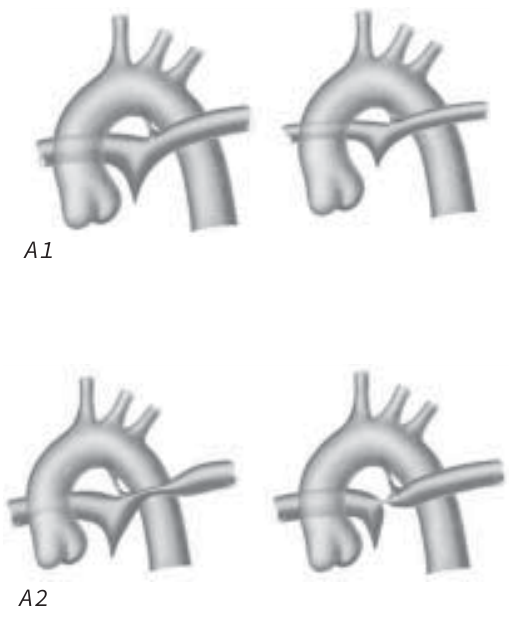
Fig. 2 – Schematic representation of subgroup A1 with normal or hypoplastic confluent pulmonary arteries and subgroup A2 with confluent and stenotic or non-confluent pulmonary